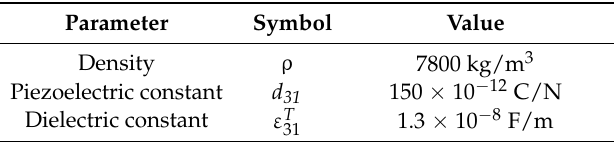
Table 1. Parameters of PZT.